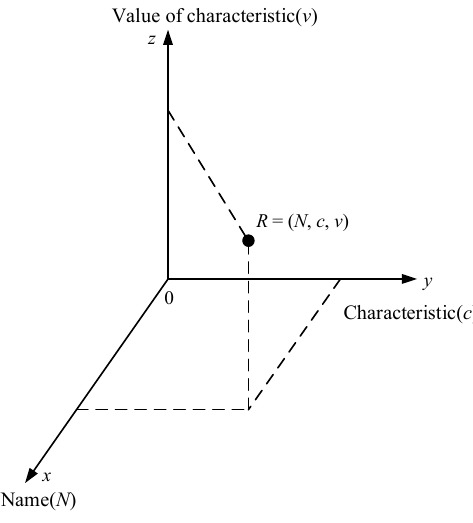
Figure 9. Space of matter elements.